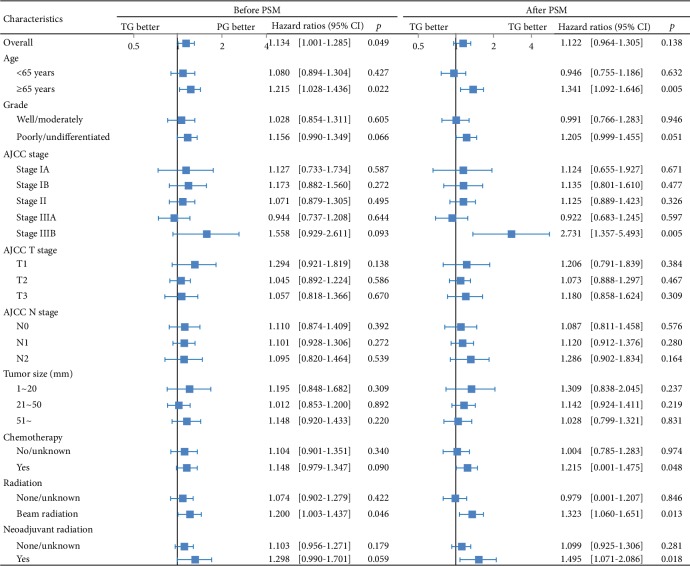
OS comparisons between PG and TG before and after the PSM in the subgroup analysis.